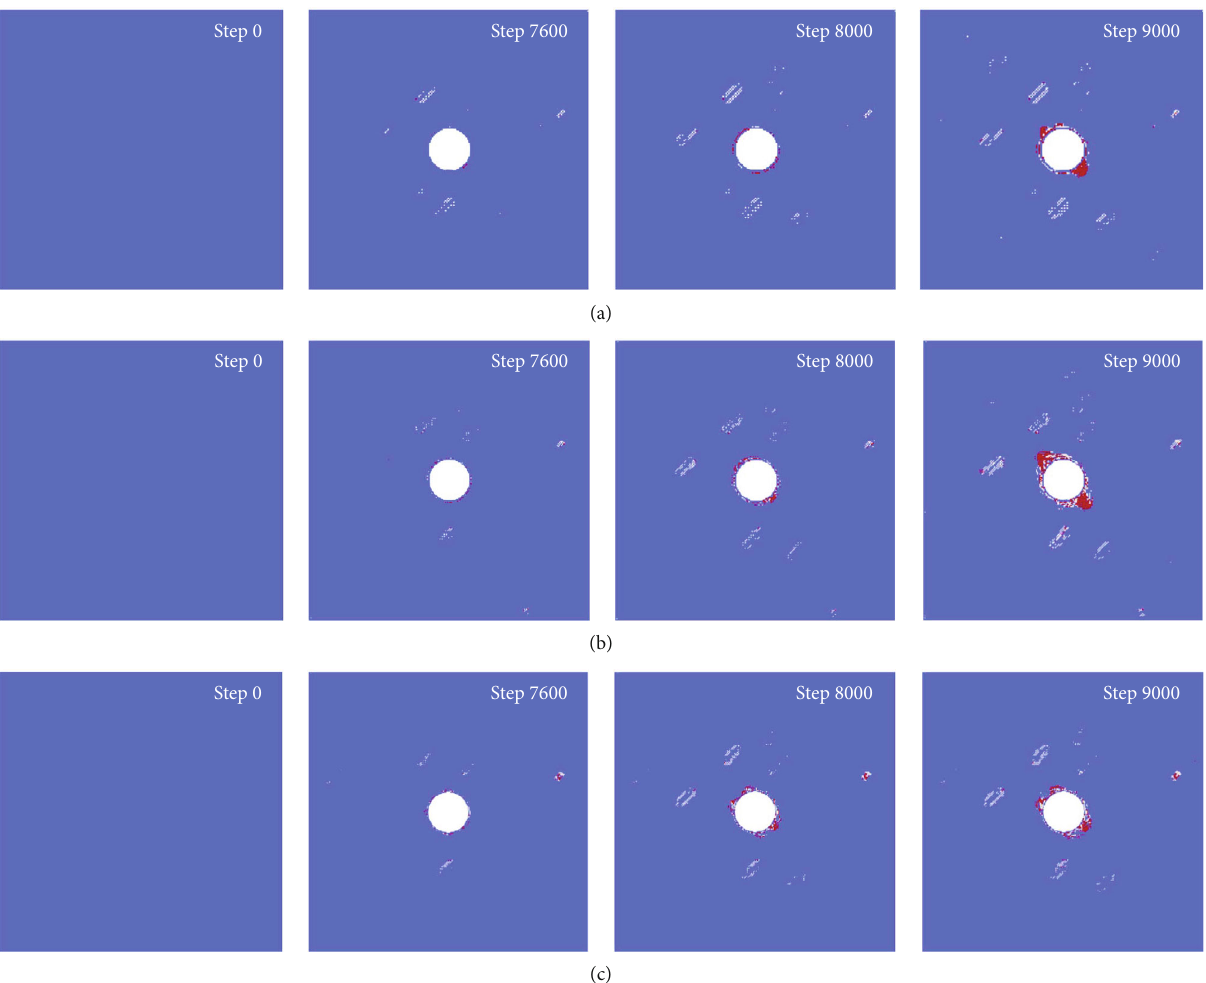
Figure 13: Comparisons between di ff erent particle numbers. (a) Particle number of 40000. (b) Particle number of 62500. (c) Particle number of